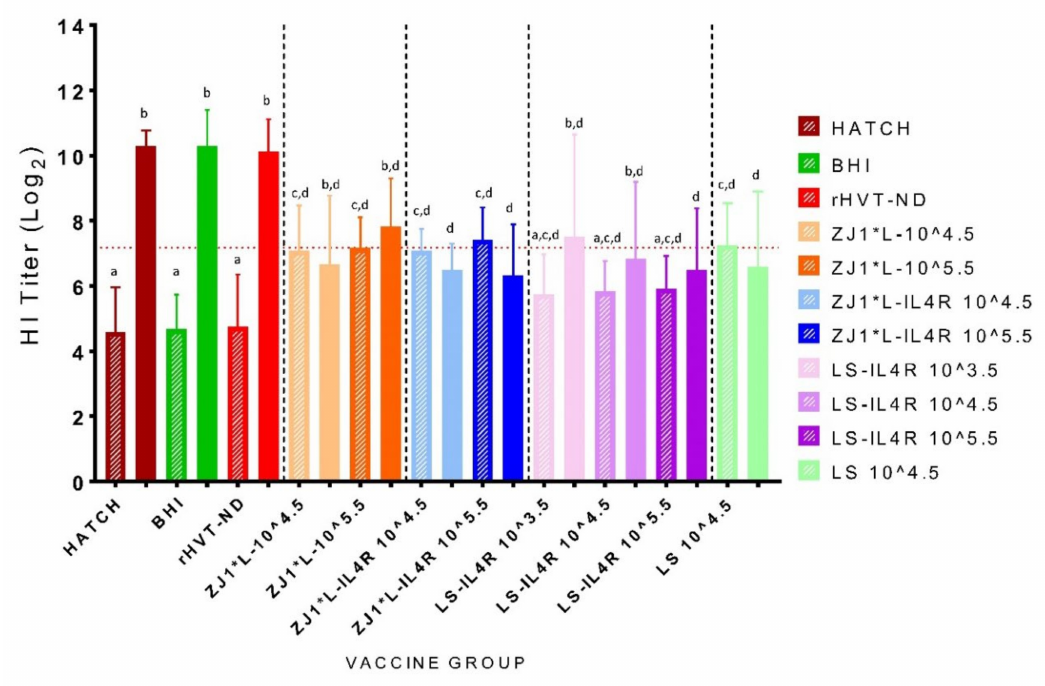
Figure 3. Pre- and post-challenge HI antibody titers (and standard deviation) from chickens hatched from commercial eggs inoculated at 18 days of embryonation with experimental in ovo vaccines and early challenge with virulent Newcastle disease virus at 14 days post-hatch.The diagonal stripe-filled bars represent the pre-challenge titers at 13 days post-hatch. The solid-filled bars represent the post-challenge titers at 14 days post-challenge. Statistically significant differences between the different groups are presented with lowercase letters above each group ( p value <0.05). The level of maternal antibodies at the day of hatch (0 DPH) is presented as a horizontal dotted line. Group abbreviations: HATCH—eggs not inoculated; BHI—eggs inoculated with BHI; rHVT-ND—eggs inoculated with recombinant HVT vaccine; ZJ1*L—eggs inoculated with the recombinant ZJ1*L virus whose cleavage site was modified to be of low virulence; ZJ1*L-IL4R—eggs inoculated with the recombinant low virulent ZJ1*L with the interleukin-4 gene inserted in reverse orientation; LS—eggs inoculated with the LaSota strain; LS-IL4R—eggs inoculated with the recombinant LaSota virus with the interleukin-4 gene inserted in reverse orientation. The virus dose that the eggs in each group received is represented as a number after the group name in EID 50 /per